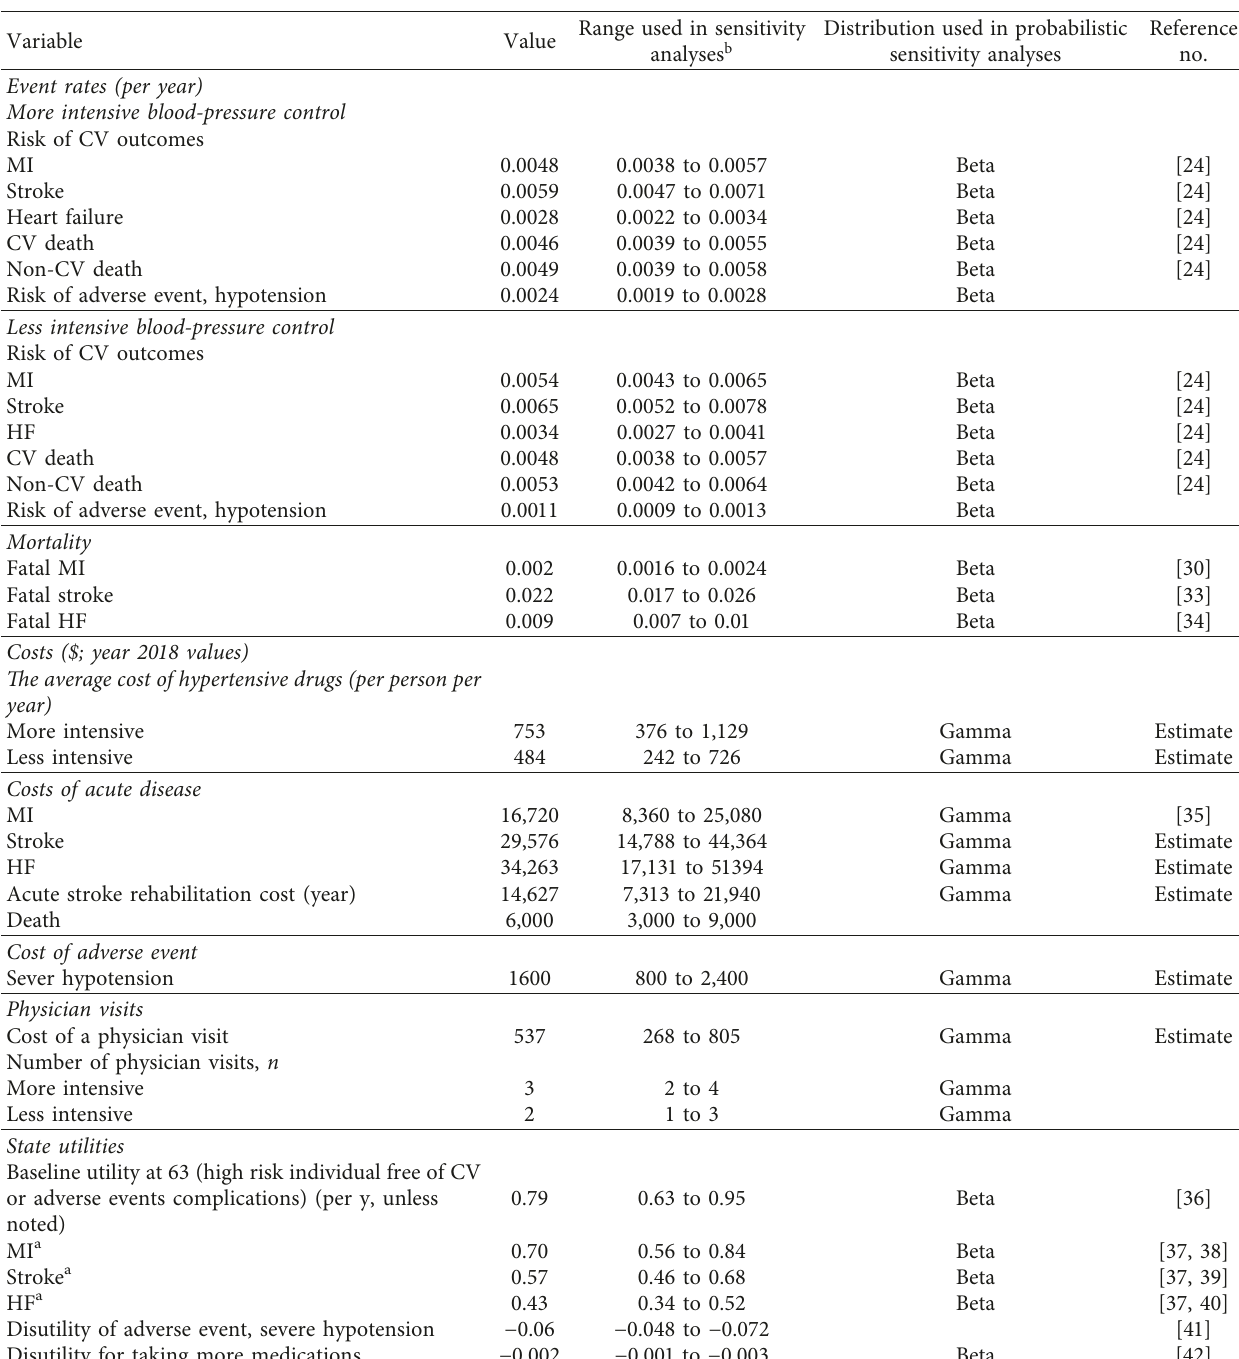
Table 1: The inputs of the economic